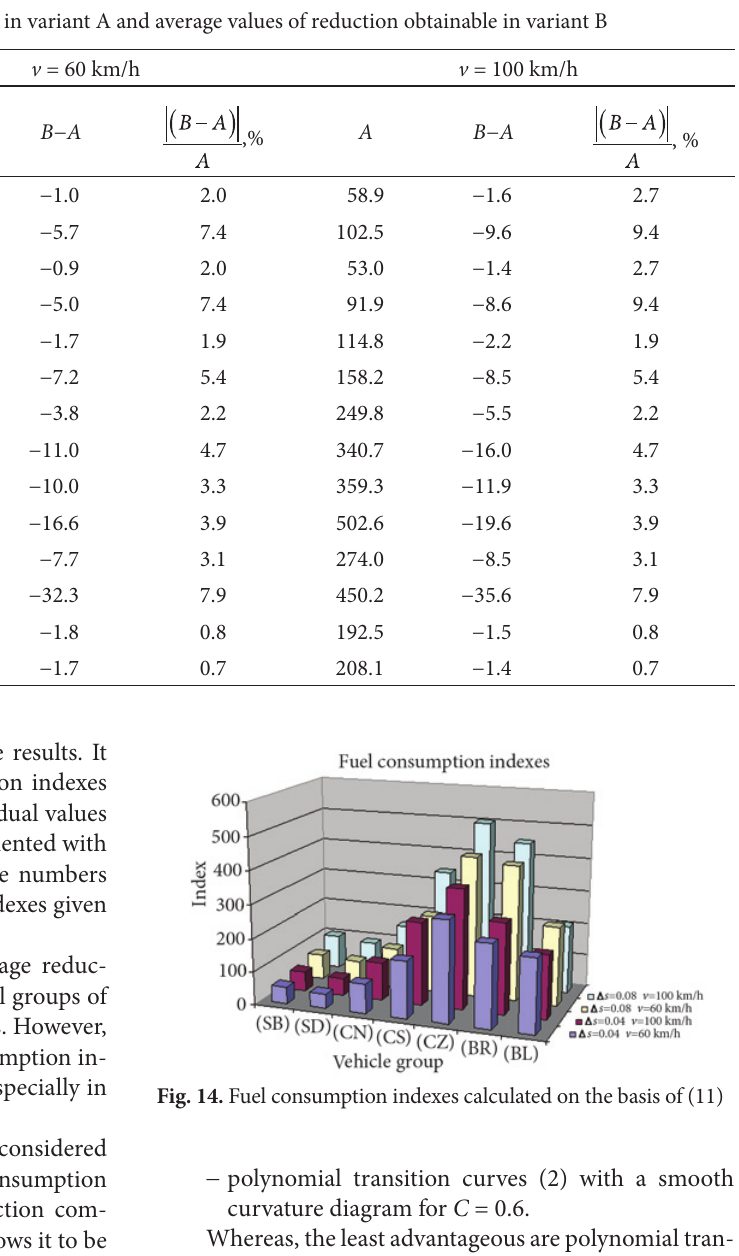
Table 6. Average values of fuel consumption indexes in variant A and average values of reduction obtainable in variant B